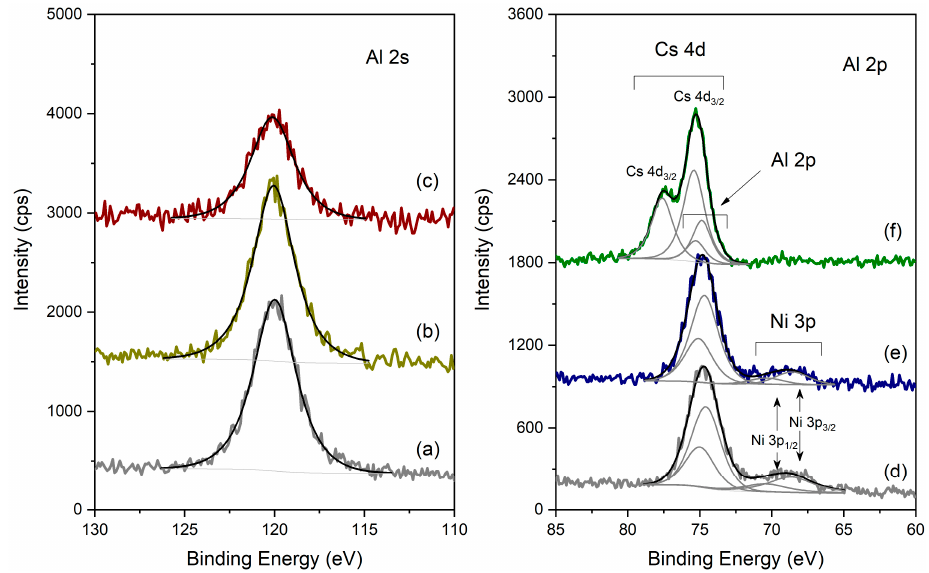
Figure 7. XPS spectra of the different catalysts in the Al 2s and Al 2p regions: (left) Al 2s region, ( a ) Pt-Al 2 O 3 ; ( b ) HPW/Pt-Al 2 O 3 , ( c ) Pt-Al 2 O 3 /Cs 2.5 ; (right) Al 2p region, ( d ) Ni-Al 2 O 3 ; ( e ) HPW/Ni-Al 2 O, ( f ) Ni-Al 2 O 3 /Cs 2.5 .